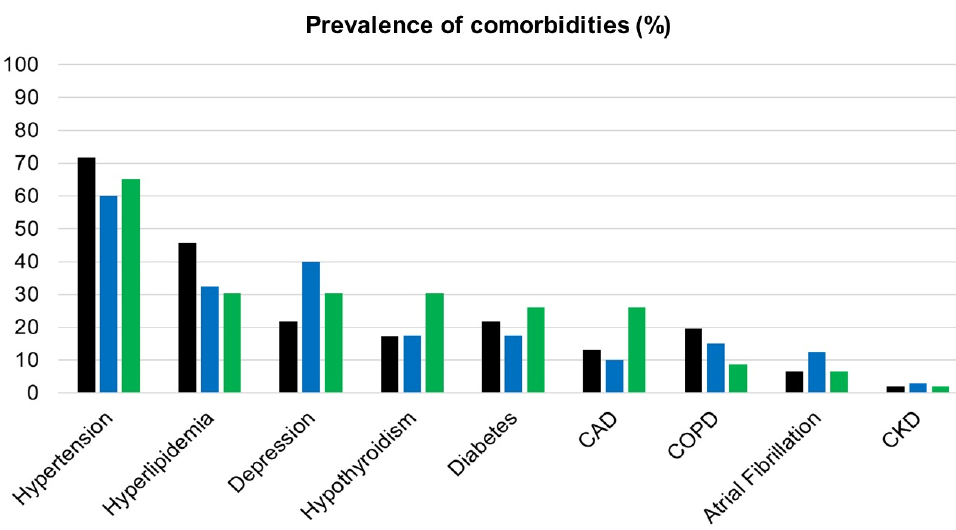
Figure 3. Different prevalence of comorbidities in the three groups: 2020-GROUP (black bars), 2019-GROUP (blue bars), and 2018-GROUP (green bars). CAD: coronary artery disease; COPD: chronic obstructive pulmonary disease; CKD: chronic kidney disease. Differences between groups were assessed with Chi-squared tests. None of the considered variables showed a statistically significant difference in the comparison between groups.